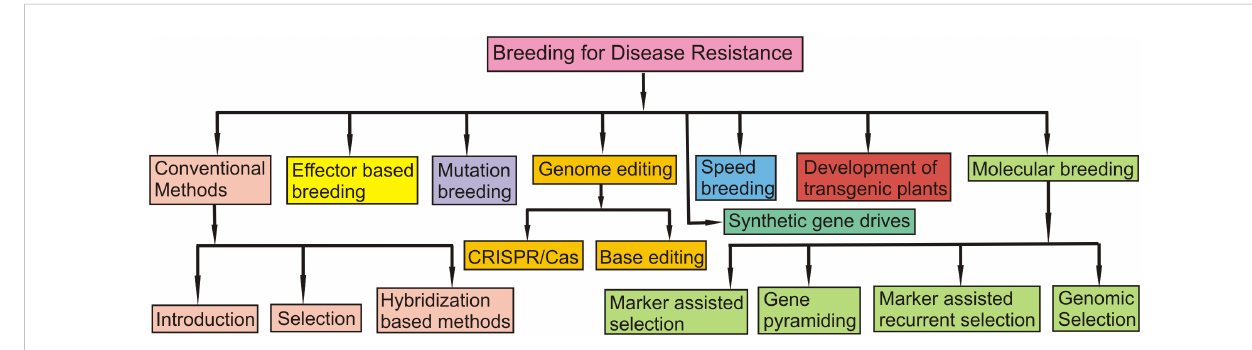
FIGURE 4 A schematic fi gure which shows a holistic view of the management of four foliar diseases through genetic